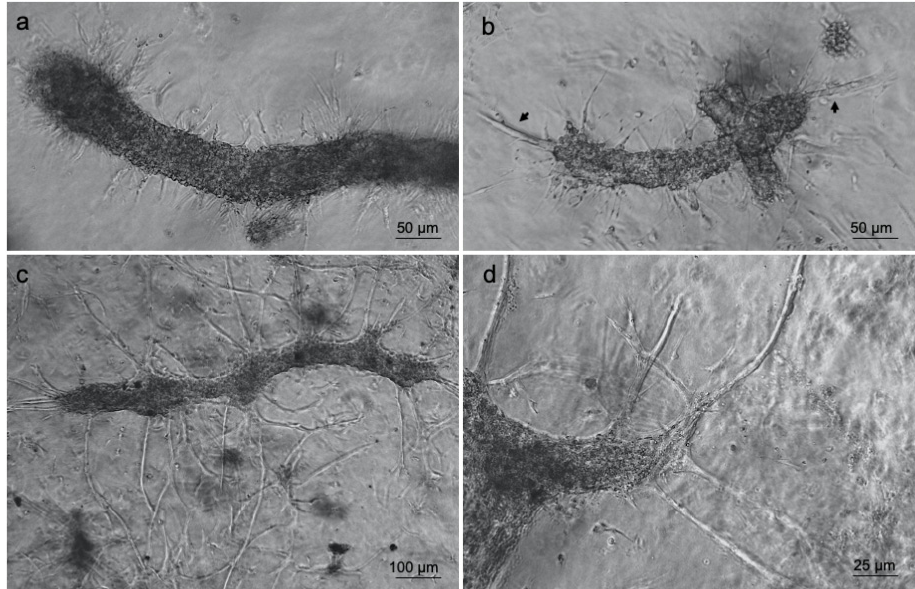
Figure 4. Type-I collagen 3D hydrogel supports ad-MVF sprouting. Optical microscopy images of ad-MVFs cultured in 3D collagen hydrogel at 2 days ( a , b ) and 8 days ( c , d ). Arrows in ( b ) indicate sprouting from tip cells.